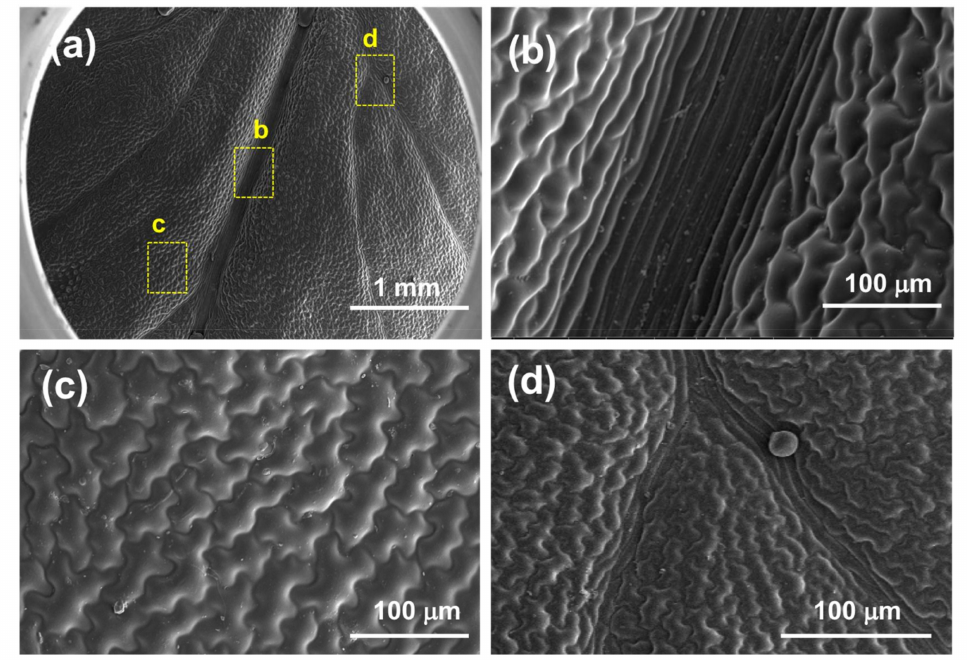
Figure 4. Scanning electron microscopy micrographs of a replicated D. marginata leaf showing ( a ) the apex part of the replicated pinnule, and ( b – d ) the replicated main channels, semicircular grooves and side channels,